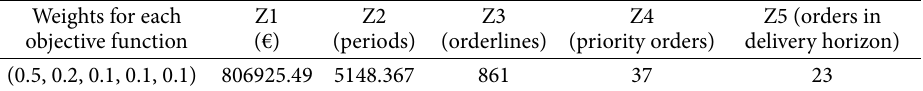
Table 4. Values of the five objectives Weights for each objective